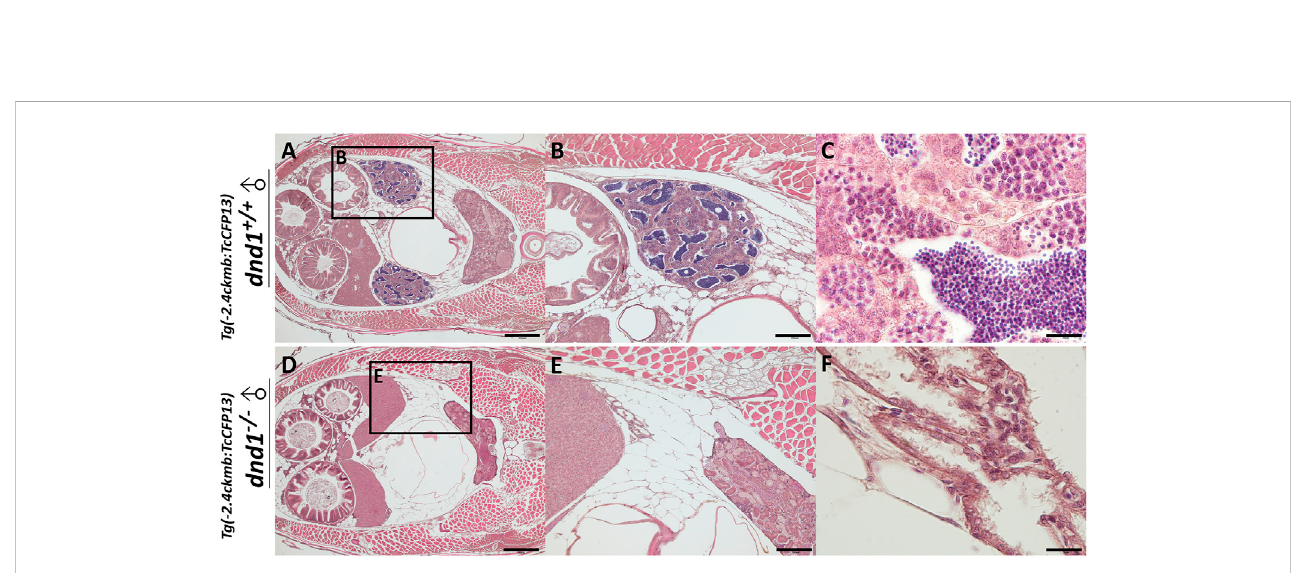
FIGURE 7 Histological analyses of fl uorescent zebra fi sh testis structure. (A)-(C) dnd1 +/+ fl uorescent zebra fi sh. (D)-(F) dnd1 -knockout homozygote fl uorescent zebra fi sh. Bars = 500 μ m (A, D) , 200 μ m (B, E) , and 20 μ m (C, F)